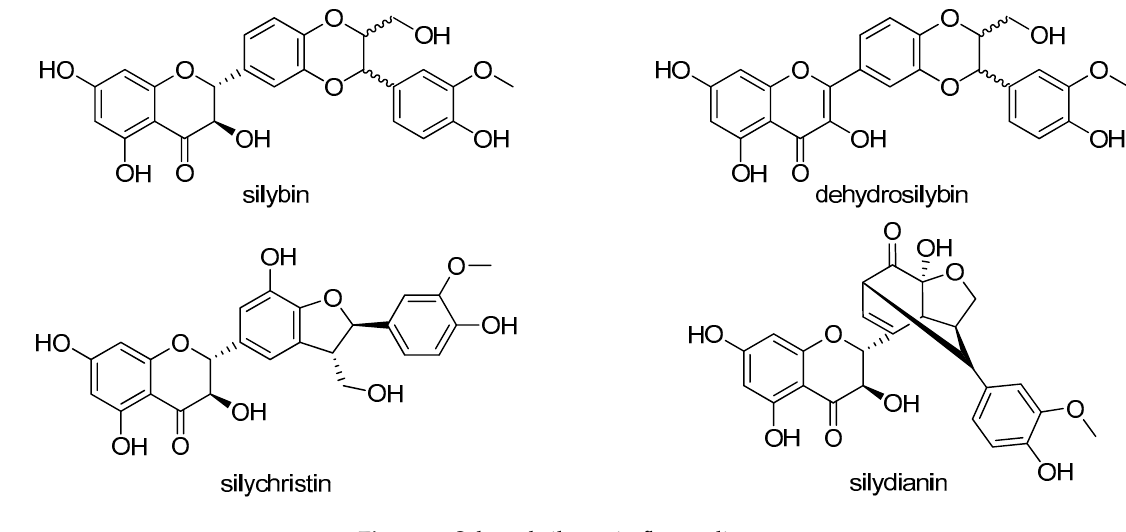
Figure 1. Selected silymarin flavonolignans.